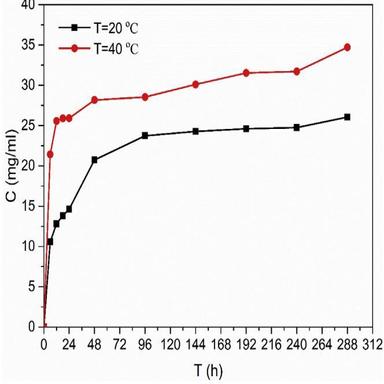
Autolytic behavior with different PVP film thickness.